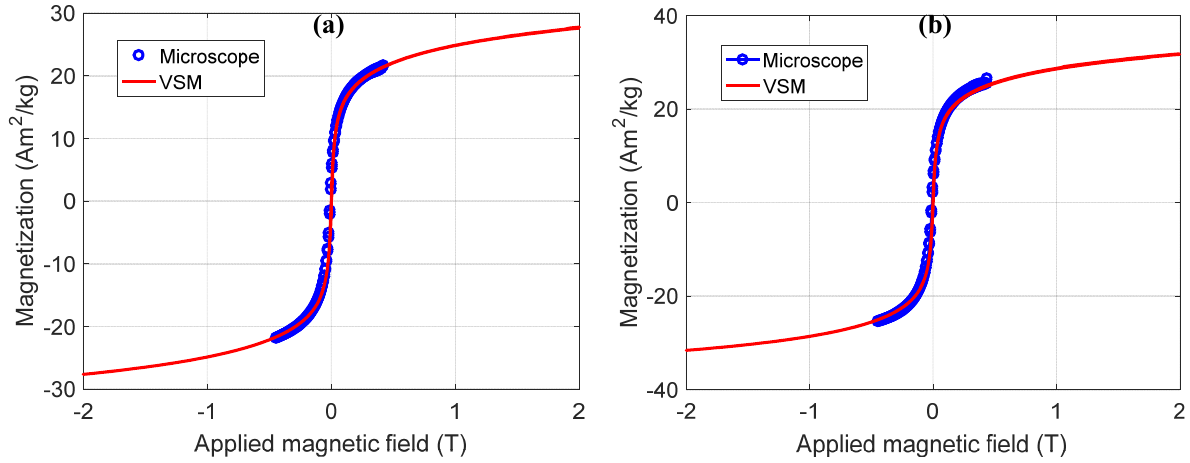
Figure 15. Magnetic hysteresis loops for two samples, measured by VSM and extracted from SMM data. ( a ) Graph representing the measurements of sample NP2. The curve composed of blue circles is the measurement made in the magnetic microscope of PUC-Rio and the continuous curve in red color is the measurement made in the commercial magnetometer of the CBPF. ( b ) Graph representing the measurements of sample NP5. The curve composed of blue circles is the measurement made in the magnetic microscope of PUC-Rio and the continuous curve in red color is the measurement made by VSM.